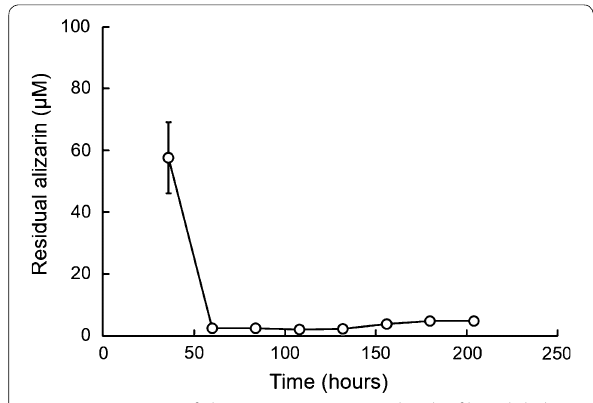
Fig. 3 Time course of alizarin concentration in broth of liquid shaking cultures inoculated with 100 μM alizarin. Data are presented as mean SD (n 3; *P < 0.05, unpaired two-tailed t ± =